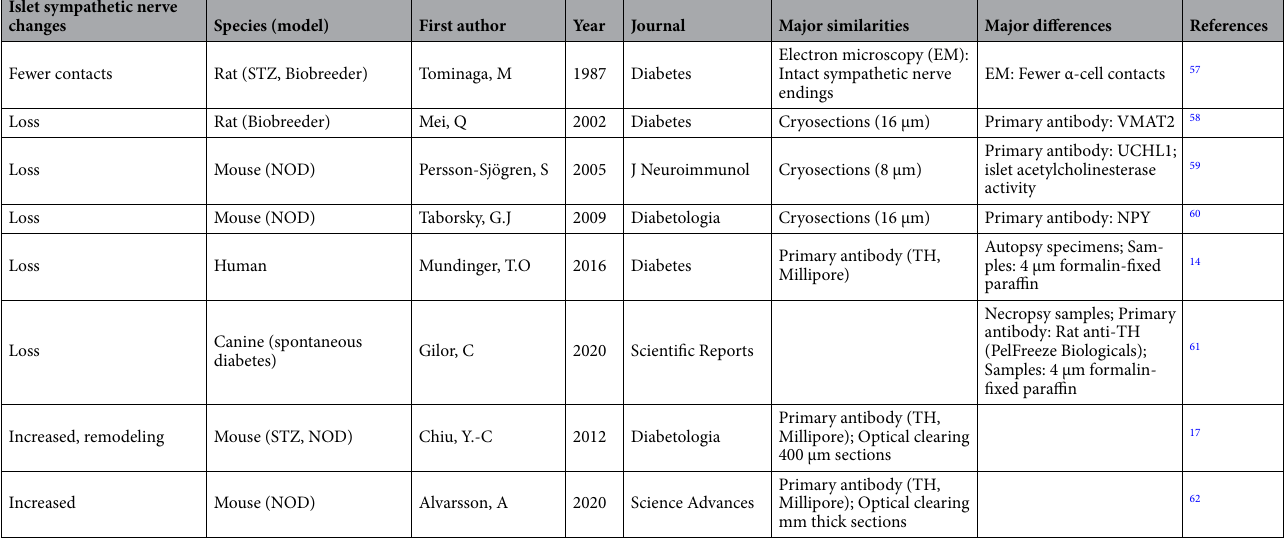
Table 1. Sympathetic innervation of islets in T1D. Studies in animal models and human demonstrating alterations (loss or no loss/increase) in islet innervation in